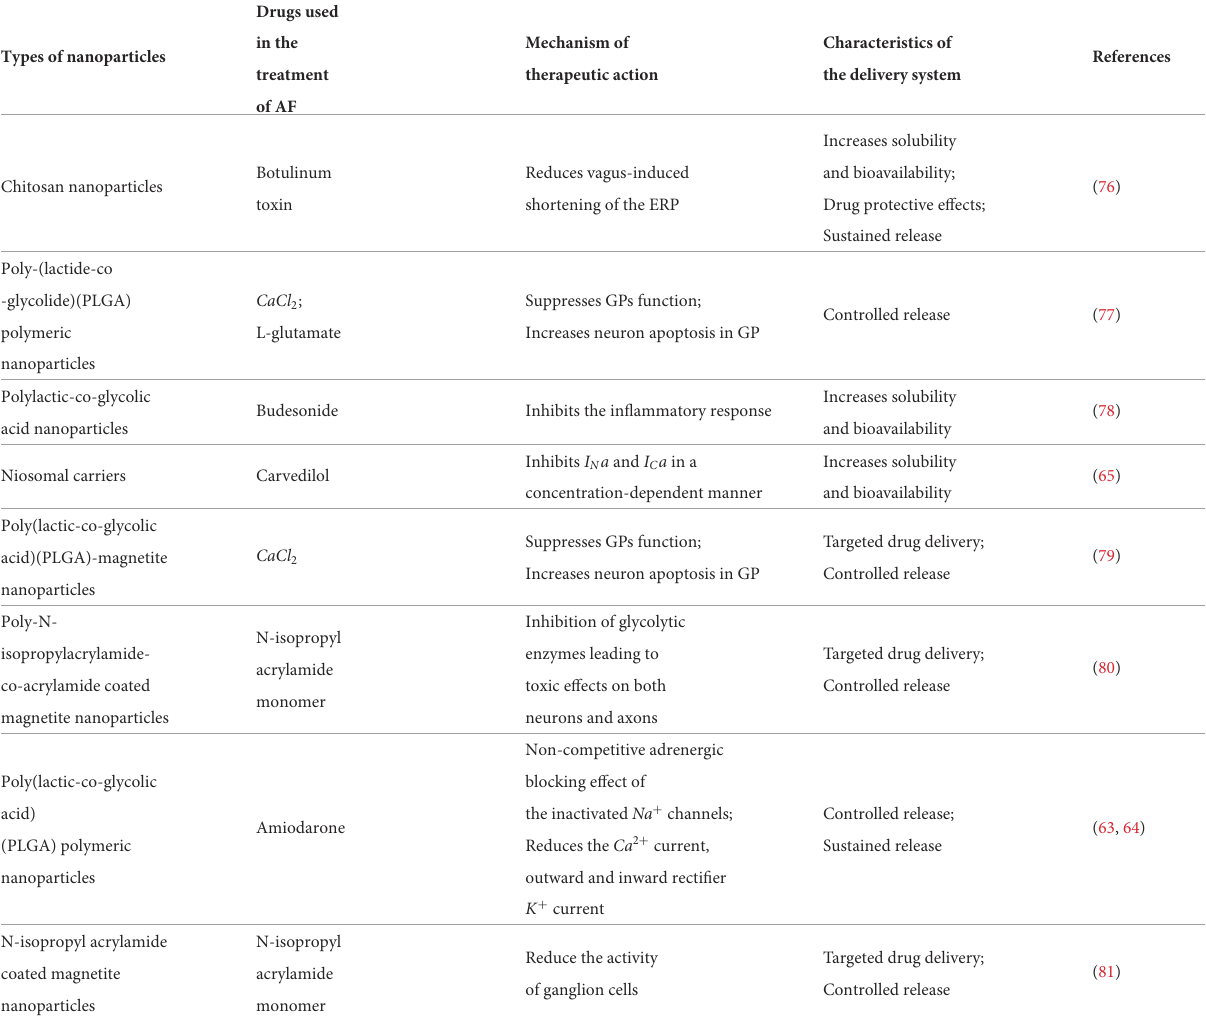
TABLE 1 Studies of nano drug delivery system for the treatment of atrial